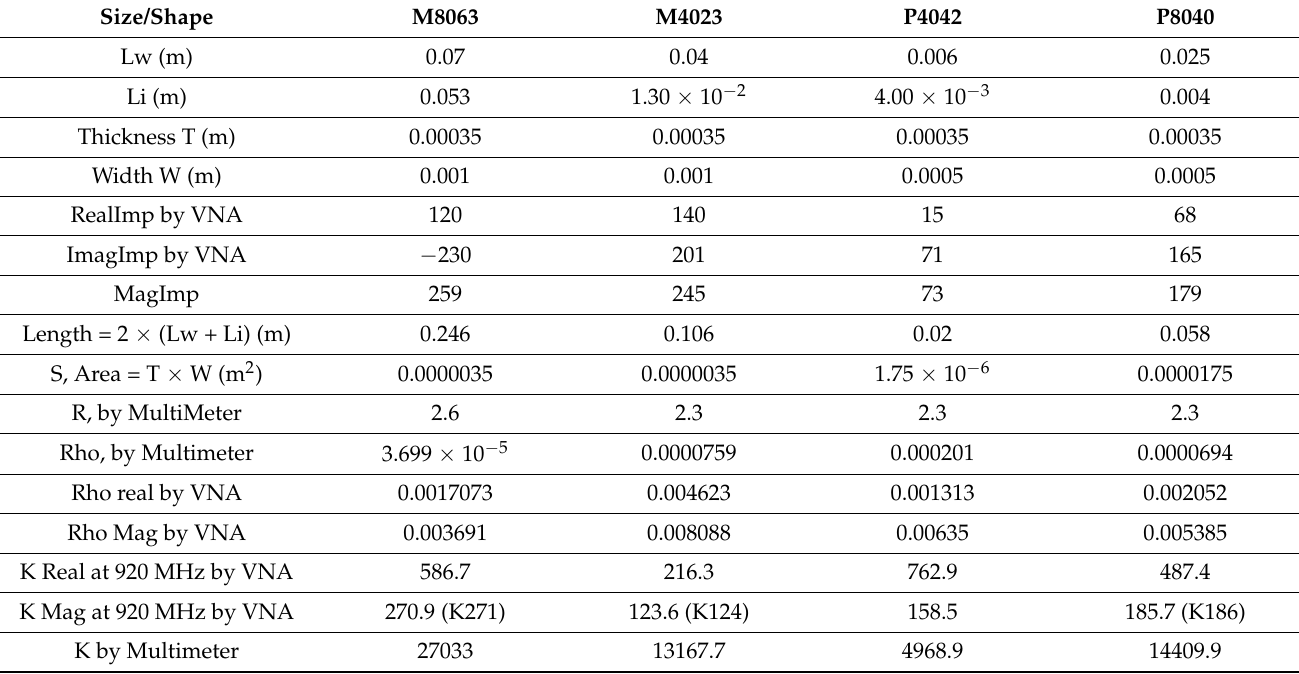
Table 1. Calculation of conductivity, K, based on the different sizes and shapes (Adafruit-1168 conductive